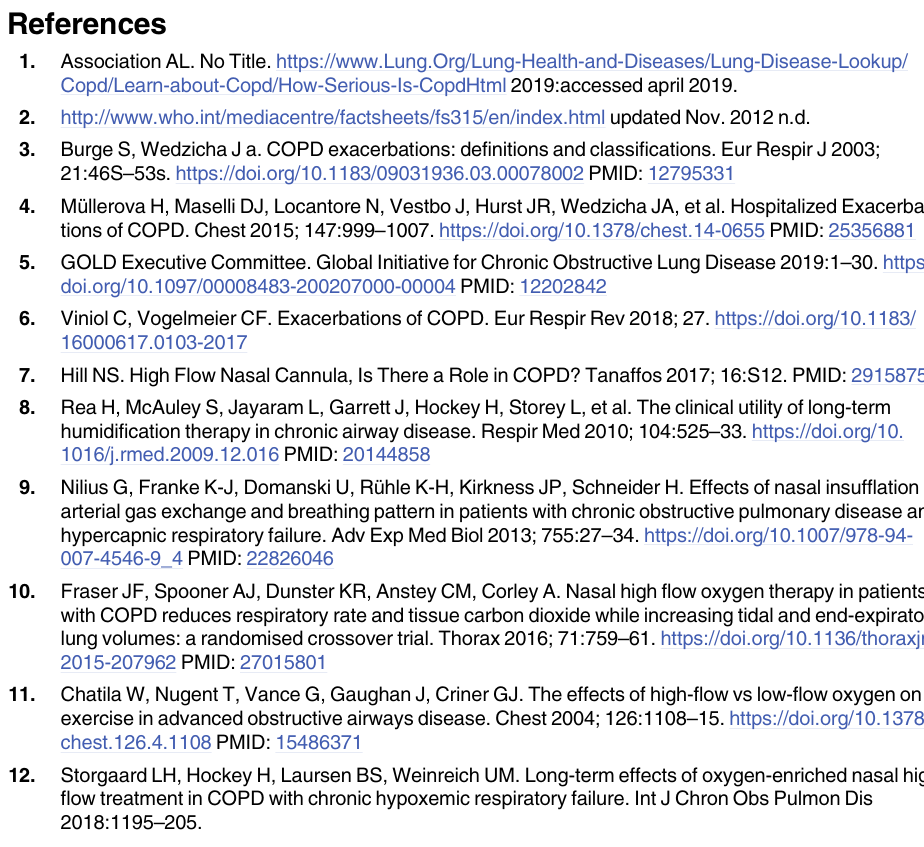
S2 Fig. Change ( Δ ) in number (N) of exacerbations, number and days of hospital admis- sions in controls and patients with 0–1 exacerbation pre study. No significant differences were seen between controls and patients with 0–1 exacerbations pre study, as demonstrated in the figure, whereas significant changes were seen between patients with 2+ exacerbations pre study and controls in Δ exacerbations (p = 0.01); Δ hospital admission (p = 0.03) and Δ admis- sion days (p <